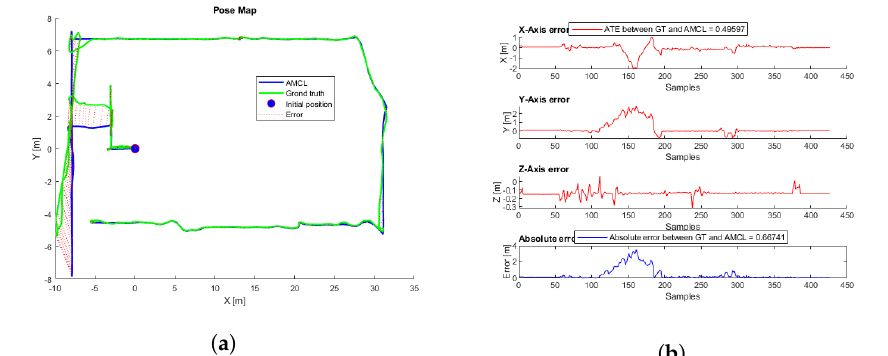
Figure 30. ICP-NL simulation test with the highest ATE. ( a ) Trajectories. ICP-NL (blue), ground truth (green), take-off position (blue circle), error (red). ( b ) ICP-N